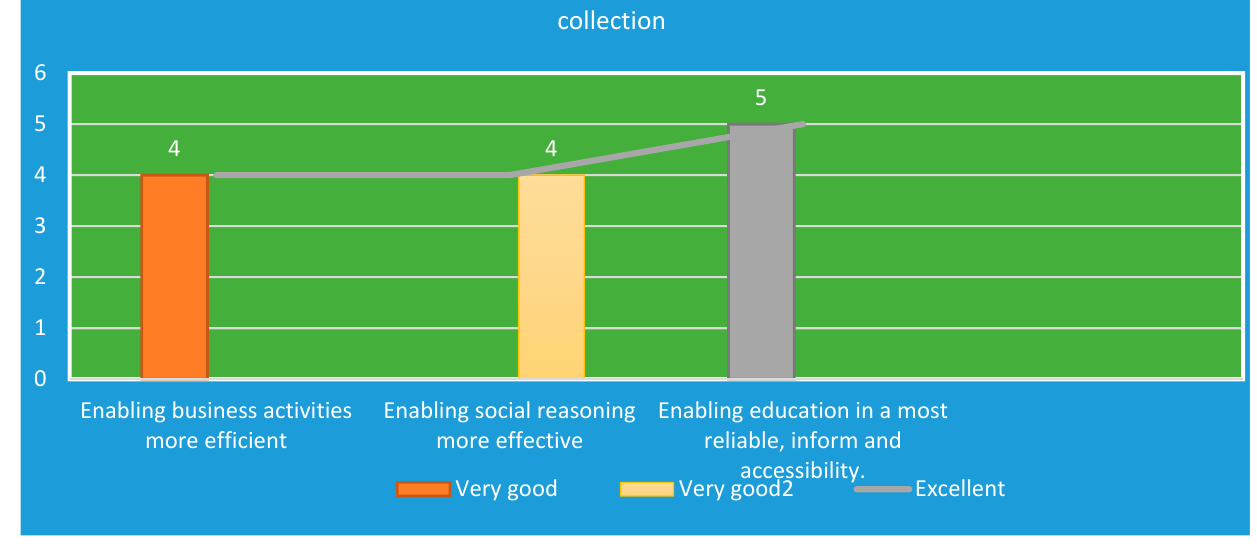
Figure 6. Behavior score influence graph of fast data collection. Determination of Behavior score of Influence of IoTs based on faster data acquisi- tion.